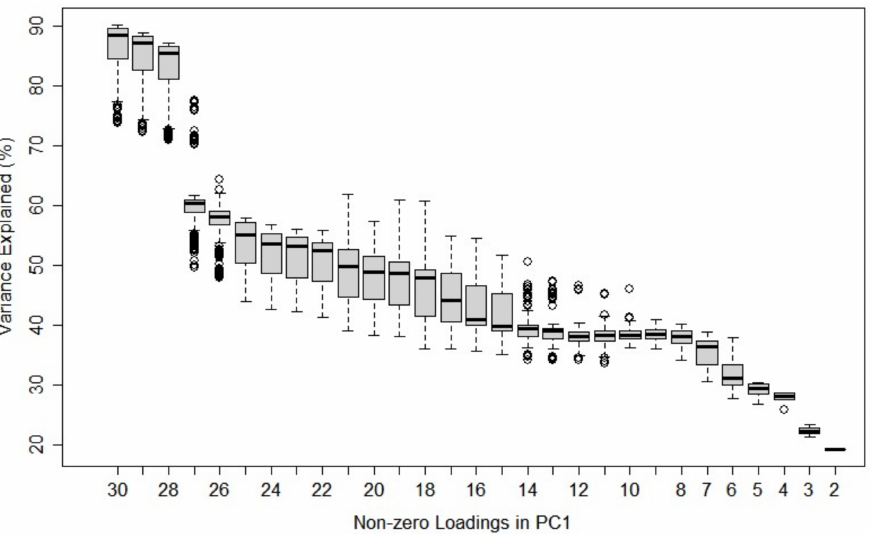
Figure 5. Distribution of variances explained by the first three sparse components for a given number of non-zero loadings in the first